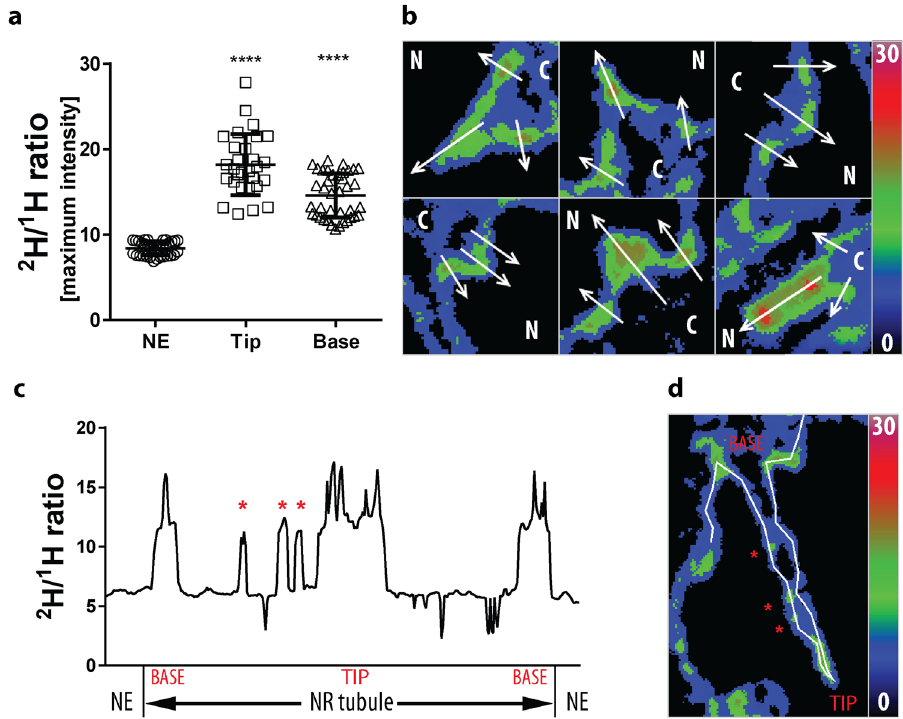
Figure 7. Quantification of the nascent phospholipid enrichment at NR structures in the NanoSIMS experiments. ( a ) Scatter plot showing maximum intensity of 2 H/ 1 H ratio at the bulk nuclear envelope (NE), and the tip and base regions of NR invaginations in mouse preadipocytes pulse labelled with deuterated choline chloride; mean ± SD indicated; **** p < 0.0001. ( b ) Examples of ratiometric images used for quantification of the 2 H/ 1 H ratios with indicated line profiles corresponding to the base region (outer arrows) or tip (middle arrow) of NR tubules; N, nucleoplasm; C, cytoplasm. Note the different appearance of these images from NanoSIMS images presented in other figures, due to using ratiometric images for measurements rather than HSI images. ( c ) Plot profile of 2 H/ 1 H ratio along a typical invagination shown in ( d ); asterisks correspond to focal PC inclusion sites along the tubule length. Colour scale of 0–30 equals 0–0.3% of 2 H/ 1 H